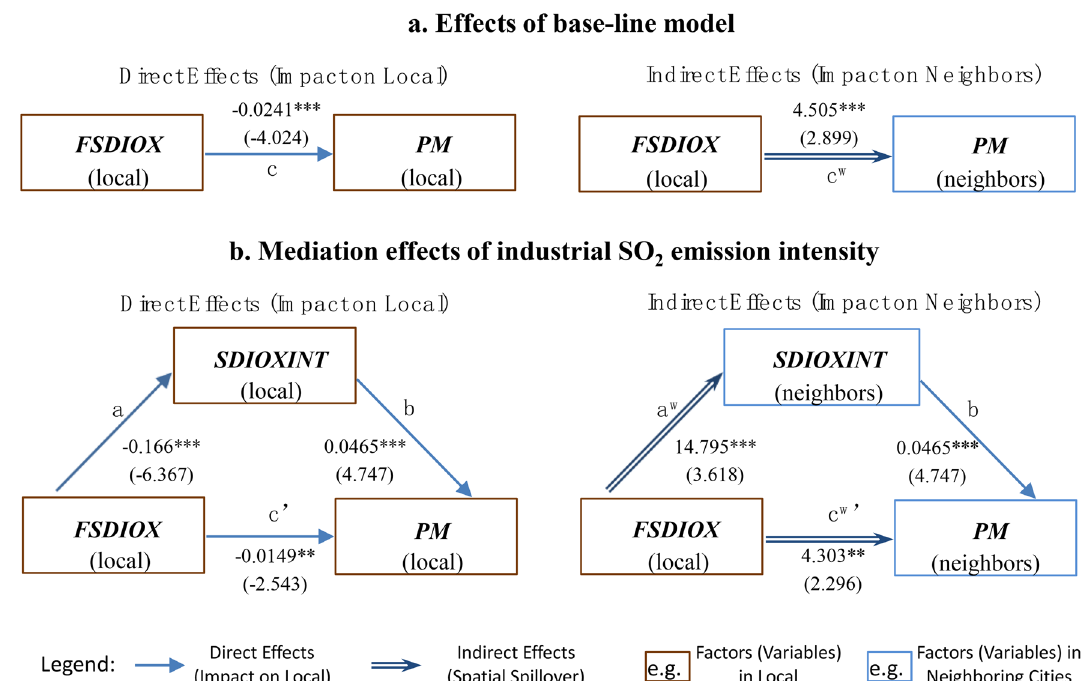
Figure 4. The mediation effects of industrial SO 2 emission intensity. Notes: ( a ) The t-statistics are marked in parentheses. *, **, and *** denote significance at 10%, 5%, and 1% levels, respectively. ( b ) It should be noted that some mediation effect studies 39 also refer to effect c’ ′ as a direct effect and refer to effect a × b as an indirect effect, so readers should pay attention to the differences between the definitions in the above studies and those in this